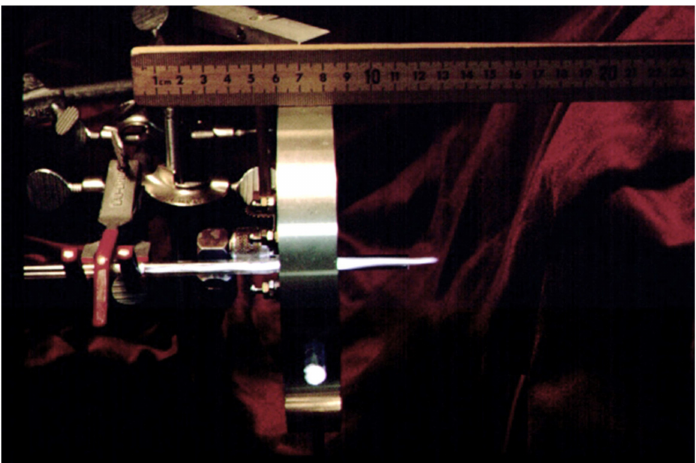
Figure 1. Ar plasma ignited in TM010 Beeknakker microwave cavity powered with 2.54 GHz generator displaying the plasma plume operating well beyond the end of the quartz capillary, possibly used for solid